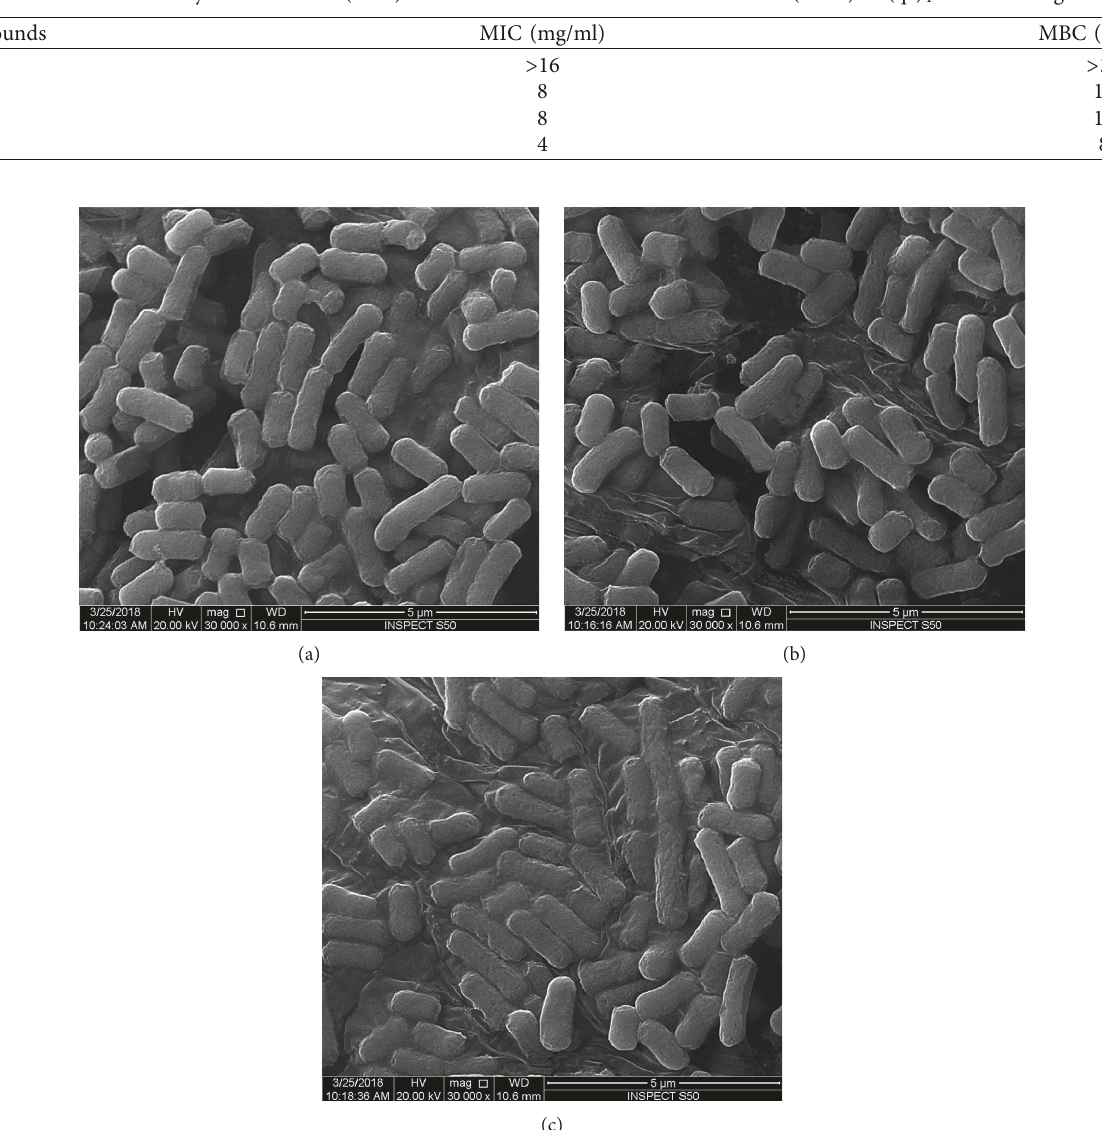
Figure 5: Scanning micrograph of E. coli : (a) E. coli control; (b, c) E. coli treated with 8 mg/ml of compound 4a